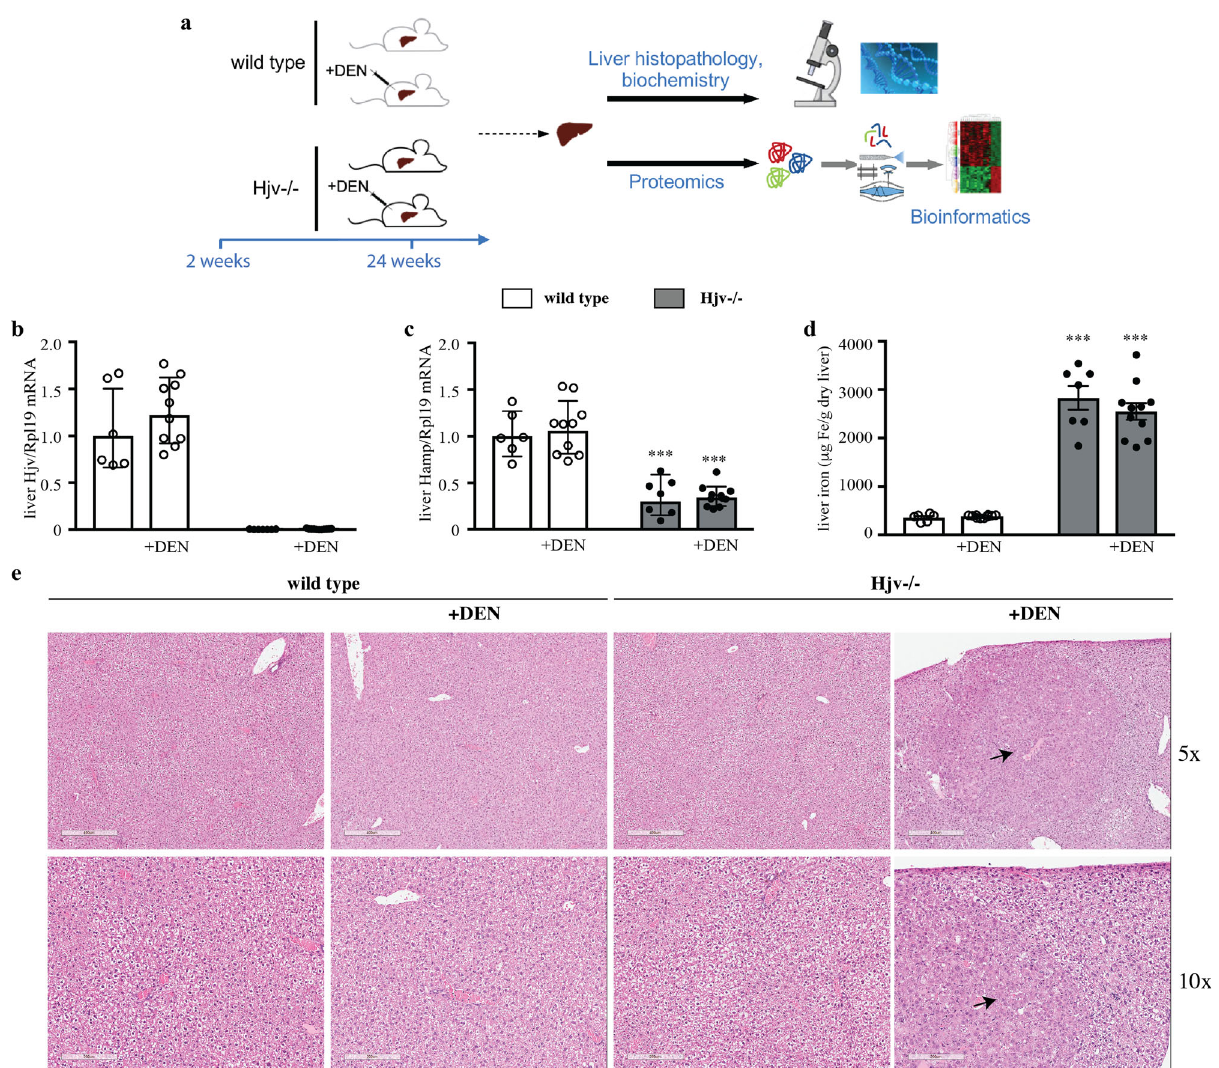
Fig. 1 Hjv − / − mice develop early HCC in response to DEN treatment. 2-week-old female wild type and Hjv − / − mice ( n = 8 – 11 per group) were injected intraperitoneally with 50 mg/kg DEN or phosphate buffered saline. All animals were sacri fi ced after 24 weeks; livers were dissected and processed for biochemical, histological and proteomics analysis. a Schematic representation of the experimental design. b qPCR analysis of Hjv mRNA. c qPCR analysis of Hamp mRNA. d Quanti fi cation of liver iron. e Histopathological analysis of liver sections by H&E staining (magni fi cations: 5x and 10x). Arrows indicate HCC lesions. Data in b – d are presented as the mean ± SEM. Statistical analysis was performed by two-way ANOVA. Statistically signi fi cant differences across genotypes are indicated by ***( p <